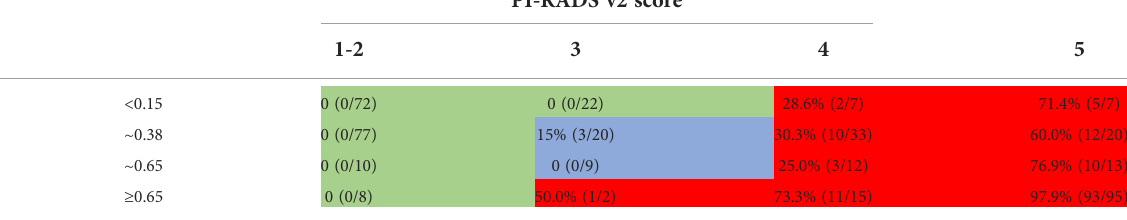
TABLE 6 Risk category of